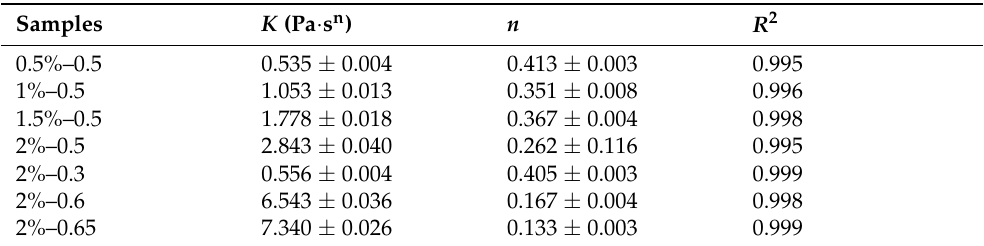
Figure 10. Viscosity of Pickering emulsions stabilized with different c (0.5–2 wt%) of LF–FD complexes at different φ (0.3–0.65): ( A ) φ = 0.5; ( B ) c = 2 wt%; storage modulus (G ′ ) and loss modulus (G ″ ) of Pickering emulsions stabilized with different c (0.5–2 wt%) of LF–FD complexes at different φ (0.3–0.65): ( C ) φ = 0.5; ( D ) c = 2 wt%. Table 2. Power law equations of Pickering emulsions stabilized with LF–FD complexes. The data are expressed as means ± SD ( n =